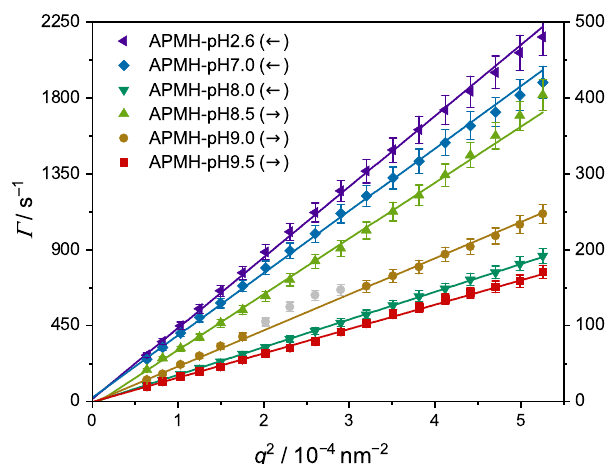
Figure 6. Relaxation rates Γ measured by angle-dependent PCS plotted against q 2 with linear regressions. Grey data points were excluded due to deviations resulting from a formfactor minimum. The corresponding ordinate is indicated by an arrow in the legend.